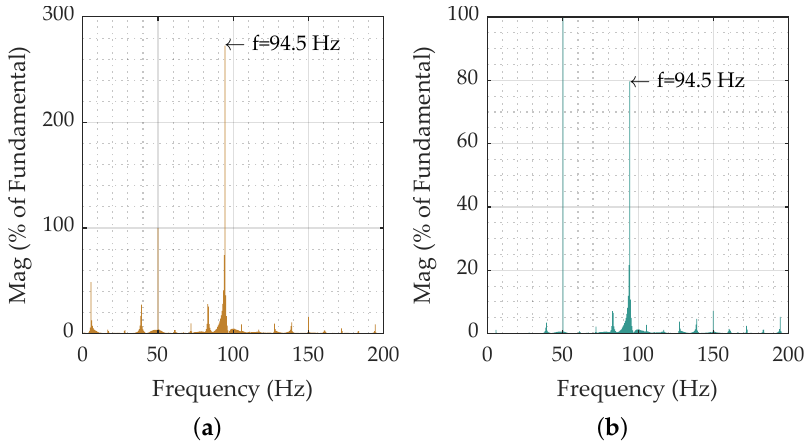
Figure 12. Fourier spectrum of phase a of the AC terminal current ( a ) and voltage ( b ) when connected to an AC grid with SCR =